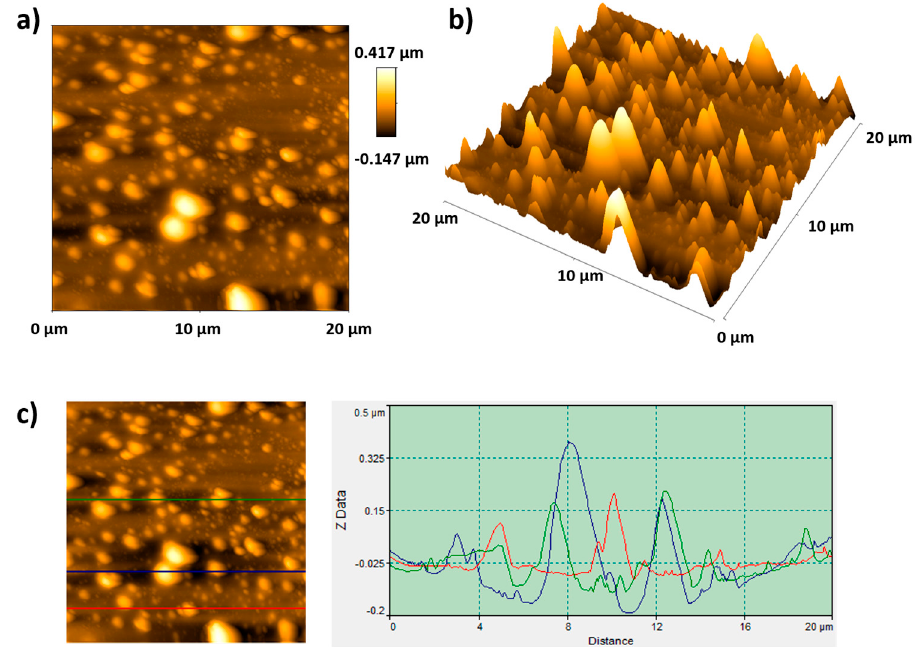
Figure 11. Atomic force microscopy (AFM) images in tapping mode of the resultant topographic surface of the sol-gel hybrid coatings in 2D ( a ), 3D ( b ), and the resultant section profiles in three different locations of the coatings ( c ).